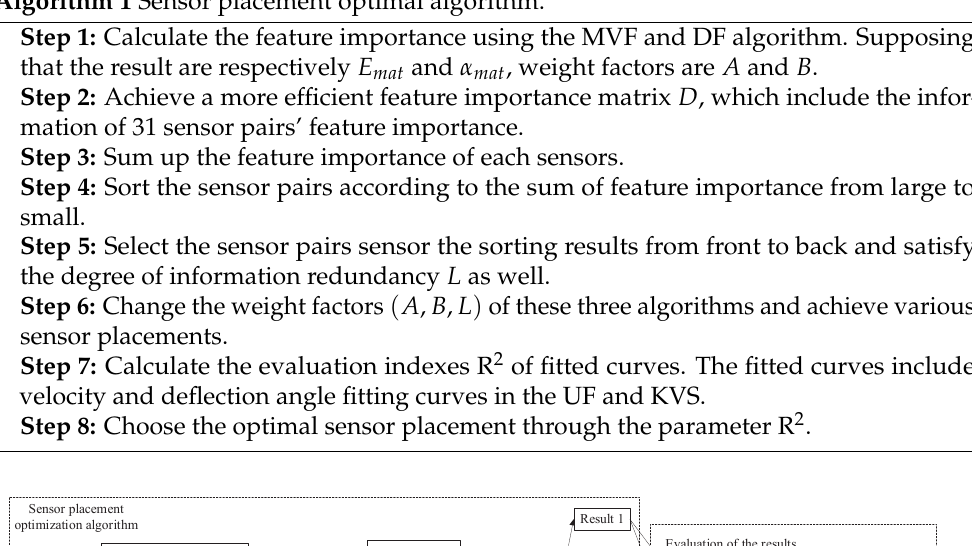
Algorithm 1 Sensor placement optimal algorithm.